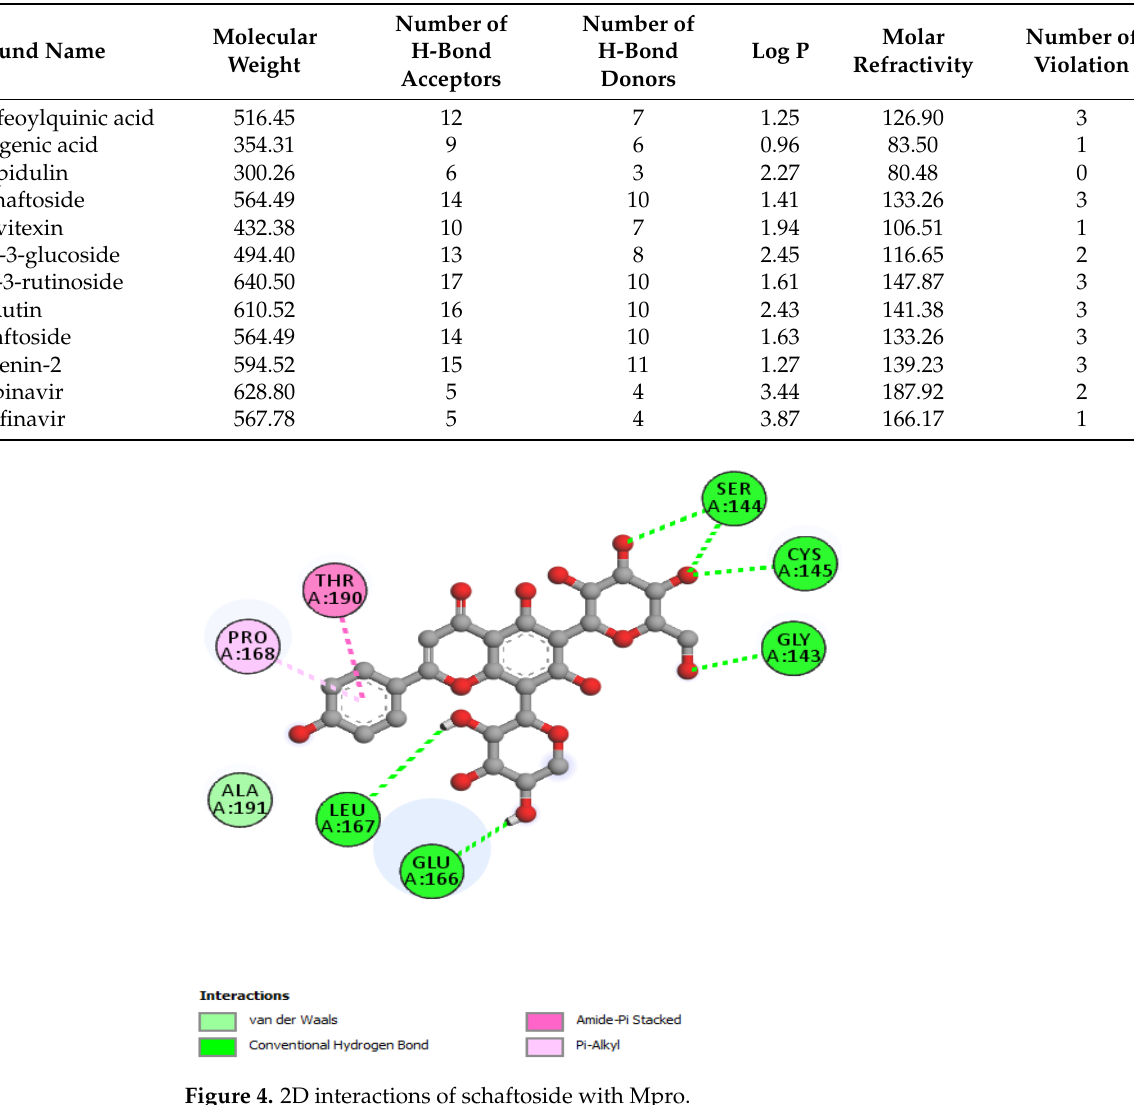
Table 3. Physico-chemical properties of selected compounds Artemisia herba-alba .